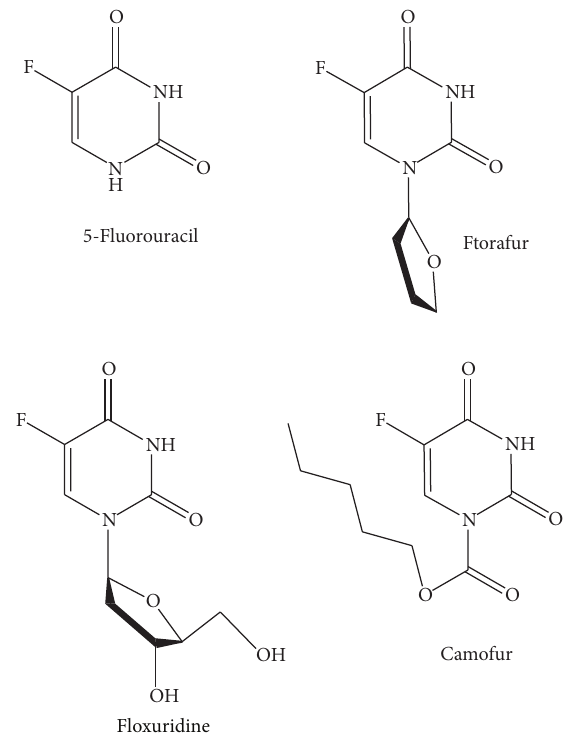
Figure 1: The most widely used prodrugs contains fluorine atoms.